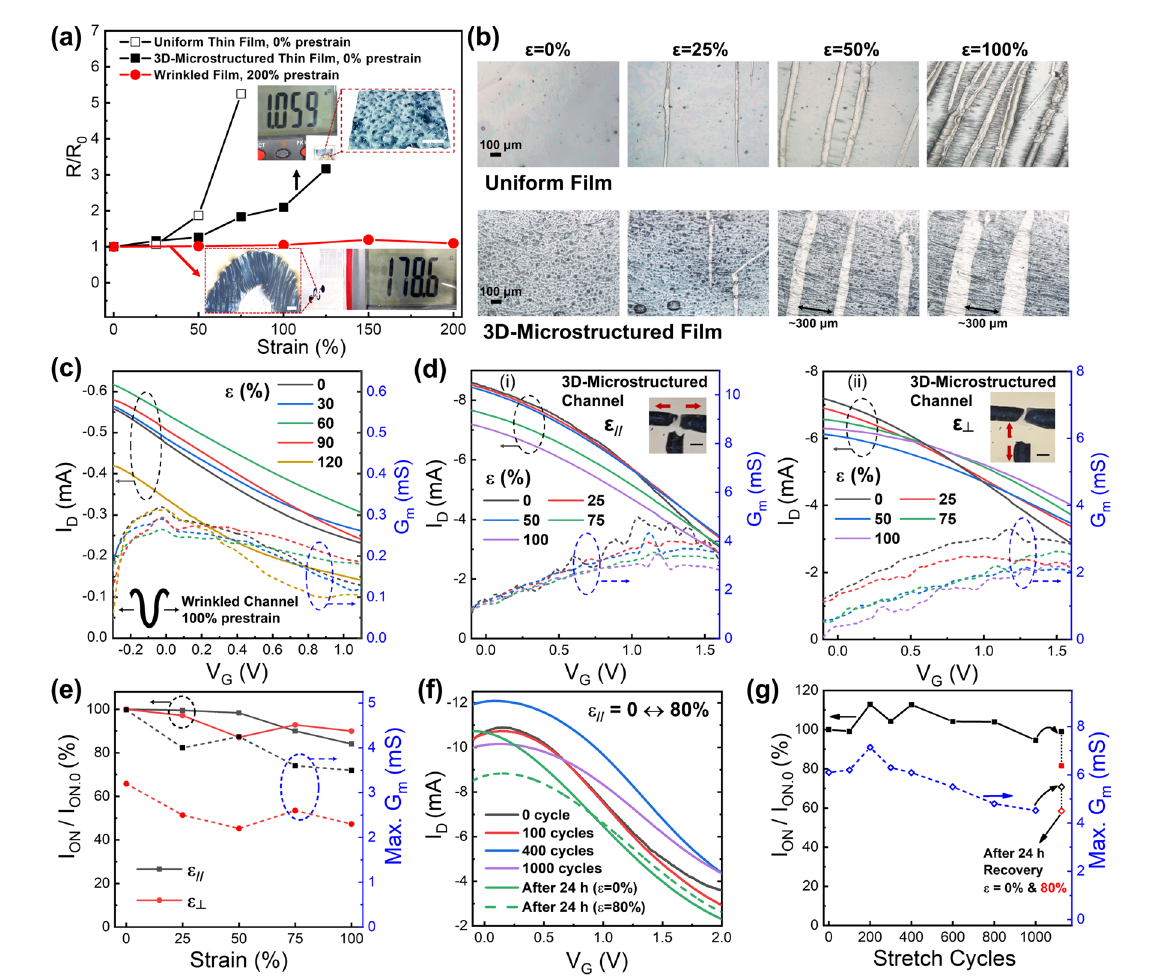
Fig. 4 a Plot of resistance variation ( R / R 0 ) for PEDOT:PSS/LiTFSI films exhibiting three types of morphologies with various strains, includ- ing spin-coated uniform and imprinted 3D-microstructured films without prestrain, and wrinkled film with 200% prestrain. Insets display the resistances and microscope images of films with imprinted microstructures and wrinkles, respectively. Scale bars in insets are 200 μm. b Opti- cal microscope images of the uniform and 3D-microstructured PEDOT:PSS/LiTFSI films under strains from 0 to 100%. c Transfer and G m curves of the all-polymer OECT with wrinkled channel (100% uniaxial prestrain) under strain from 0 to 120%. d Transfer and G m curves of the all-polymer OECT with 3D-microstructured channel under 0–100% strain in both the parallel ( ε // , i) and perpendicular ( ε ┴ , ii) directions. Inset photos show the device under ~ 50% strain in each axis, respectively. Scale bars in insets are 1 mm. e Plots of I ON / I ON.0 and G m with the strain in the biaxial directions. f Transfer curves and g plots of I ON and G m variations for the 3D-microstructured channel during the repeated stretching at 80% strain for 1000 cycles. After recovery for 24 h, the device exhibited improved performance and remained highly stretchable to 80% strain. All PEDOT:PSS were added with 2 wt%